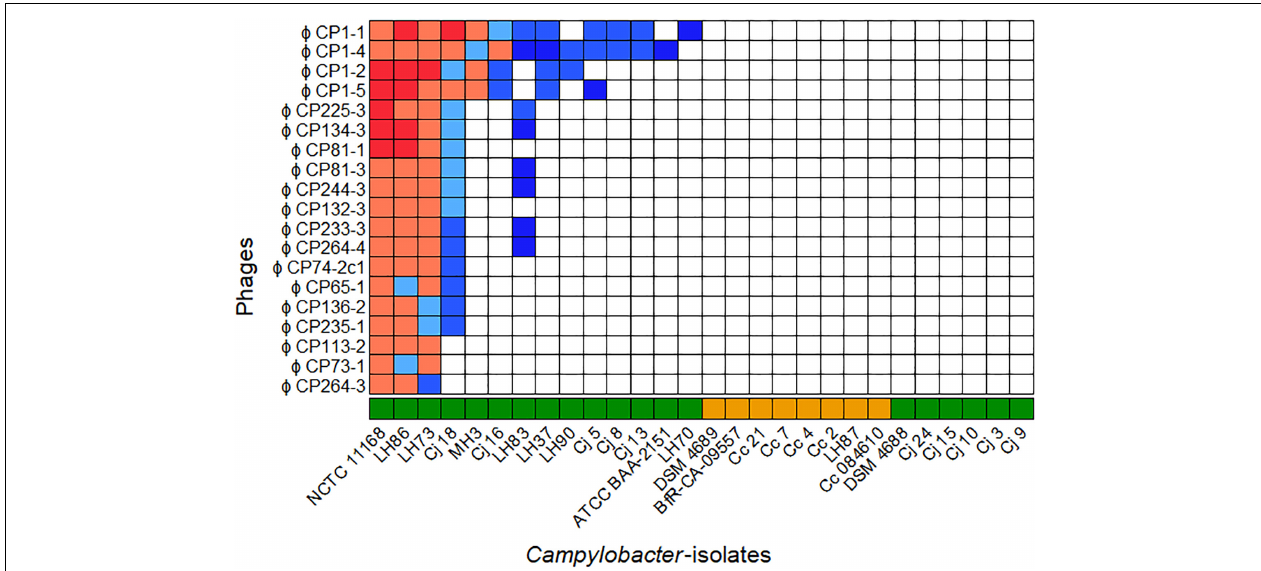
FIGURE 1 | Host ranges of 19 phages isolated in 2015 and 2017 on 28 Campylobacter spp. Overall, seven host range patterns could be distinguished. The bacteriophages vB_CjM-LmqsCP1-4 (CP1-4), vB_CjM-LmqsCP1-5 (CP1-5), vB_CjM-LmqsCP74-2c1 (CP74-2c1), and vB_CjM-LmqsCP132-3c (CP132-3c) were selected for further investigations, showing three different host range patterns. Host range evaluation was performed by spotting serial dilutions of bacteriophages onto NZCYM-soft agar overlays inoculated with Campylobacter ( C . jejuni , C . coli ). Experiments were performed in triplicate. The concentration (plaque forming units/ml) on different hosts was calculated and divided by the concentration determined on C . jejuni NCTC 12662. Color coding was used to visualize the EOP values (cid:0) x > 1 , 1 ≤ x < 0 . 9 , 0 . 9 ≤ x < 0 . 8 , 0 . 8 ≤ x < 0 . 6 , 0 . 6 ≤ x < 0 , (cid:3) x = 0 (cid:1) .